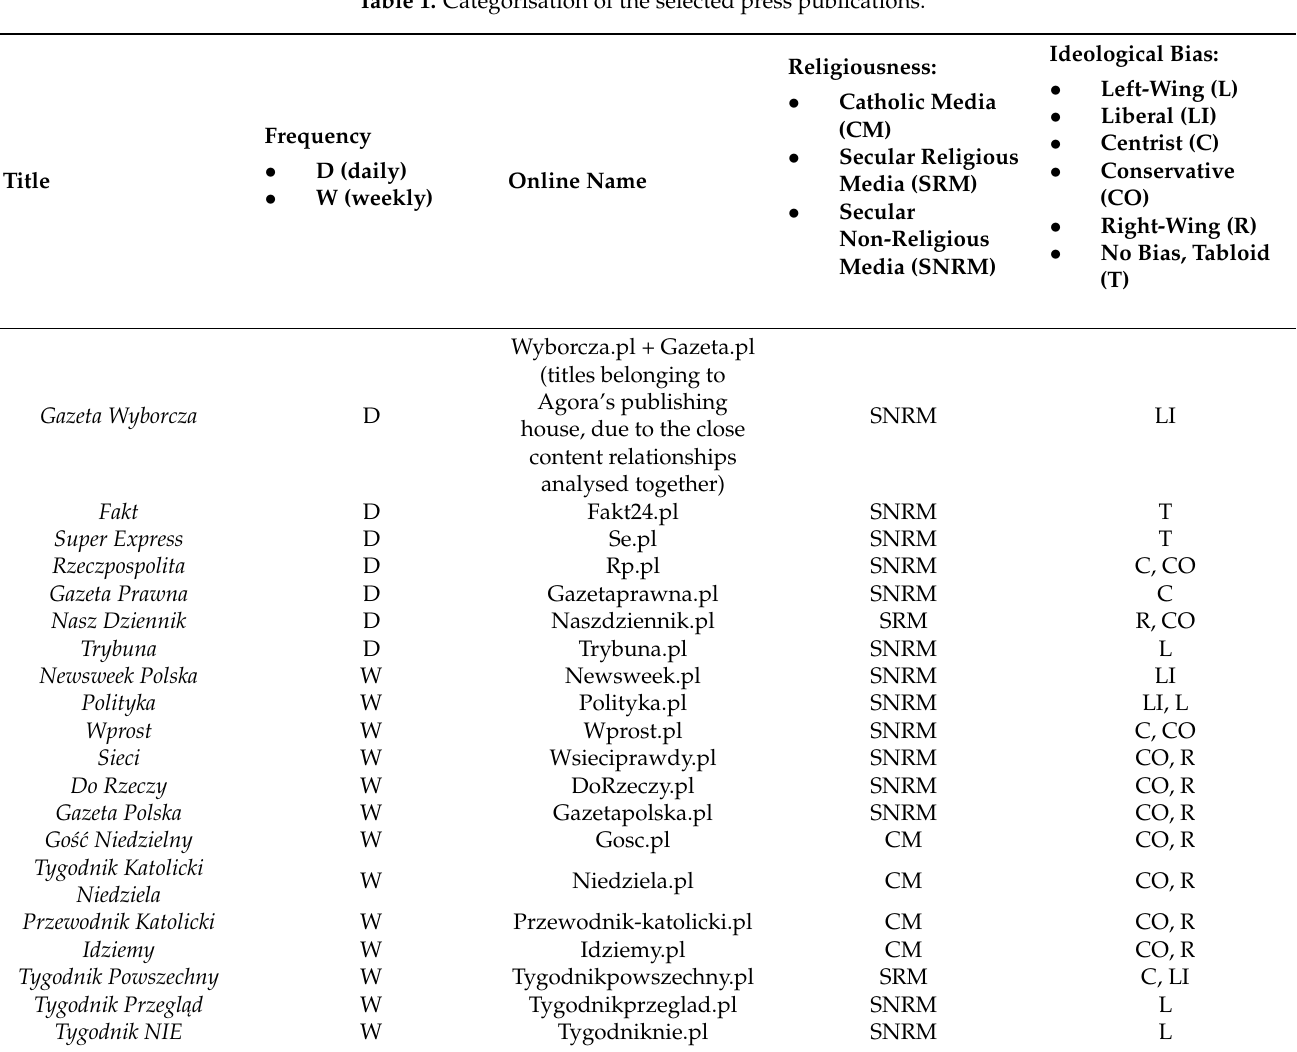
Table 1. Categorisation of the selected press